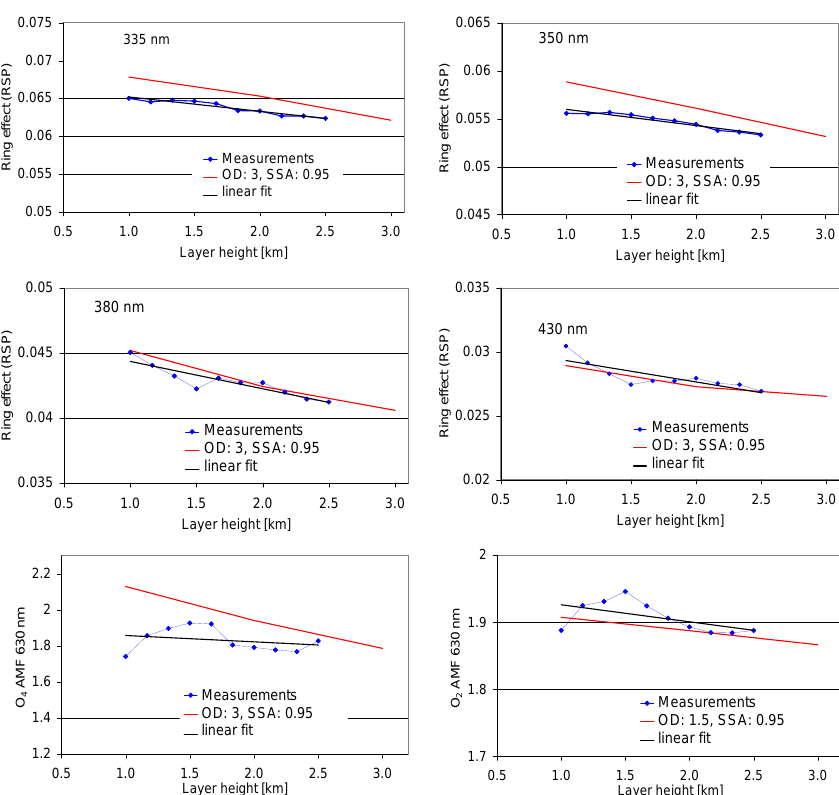
Fig. 15 Observed (blue dots) and simulated dependency of the Ring effect and the O 4 and O 2 absorption on the aerosol layer height over the area south of Beijing on September 17, 2006 (see Fig. 14). For the radiative transfer calculations the following properties were assumed: surface albedo: 10% (630 nm) and 5% (all other wavelengths), aerosol SSA: 0.95; g: 0.68, AOD: 1.5 (630 nm) and 3 (all other wavelengths). Note that the simulated O 2 AMFs were corrected for the saturation effect (see section 3).